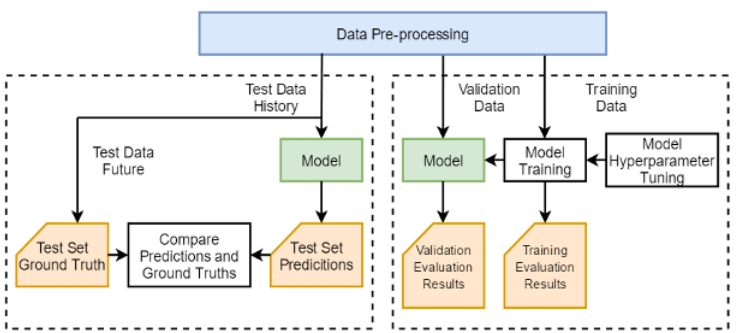
Fig. 1. Architecture block diagram of network intrusion early warning and prediction system based on Gru.